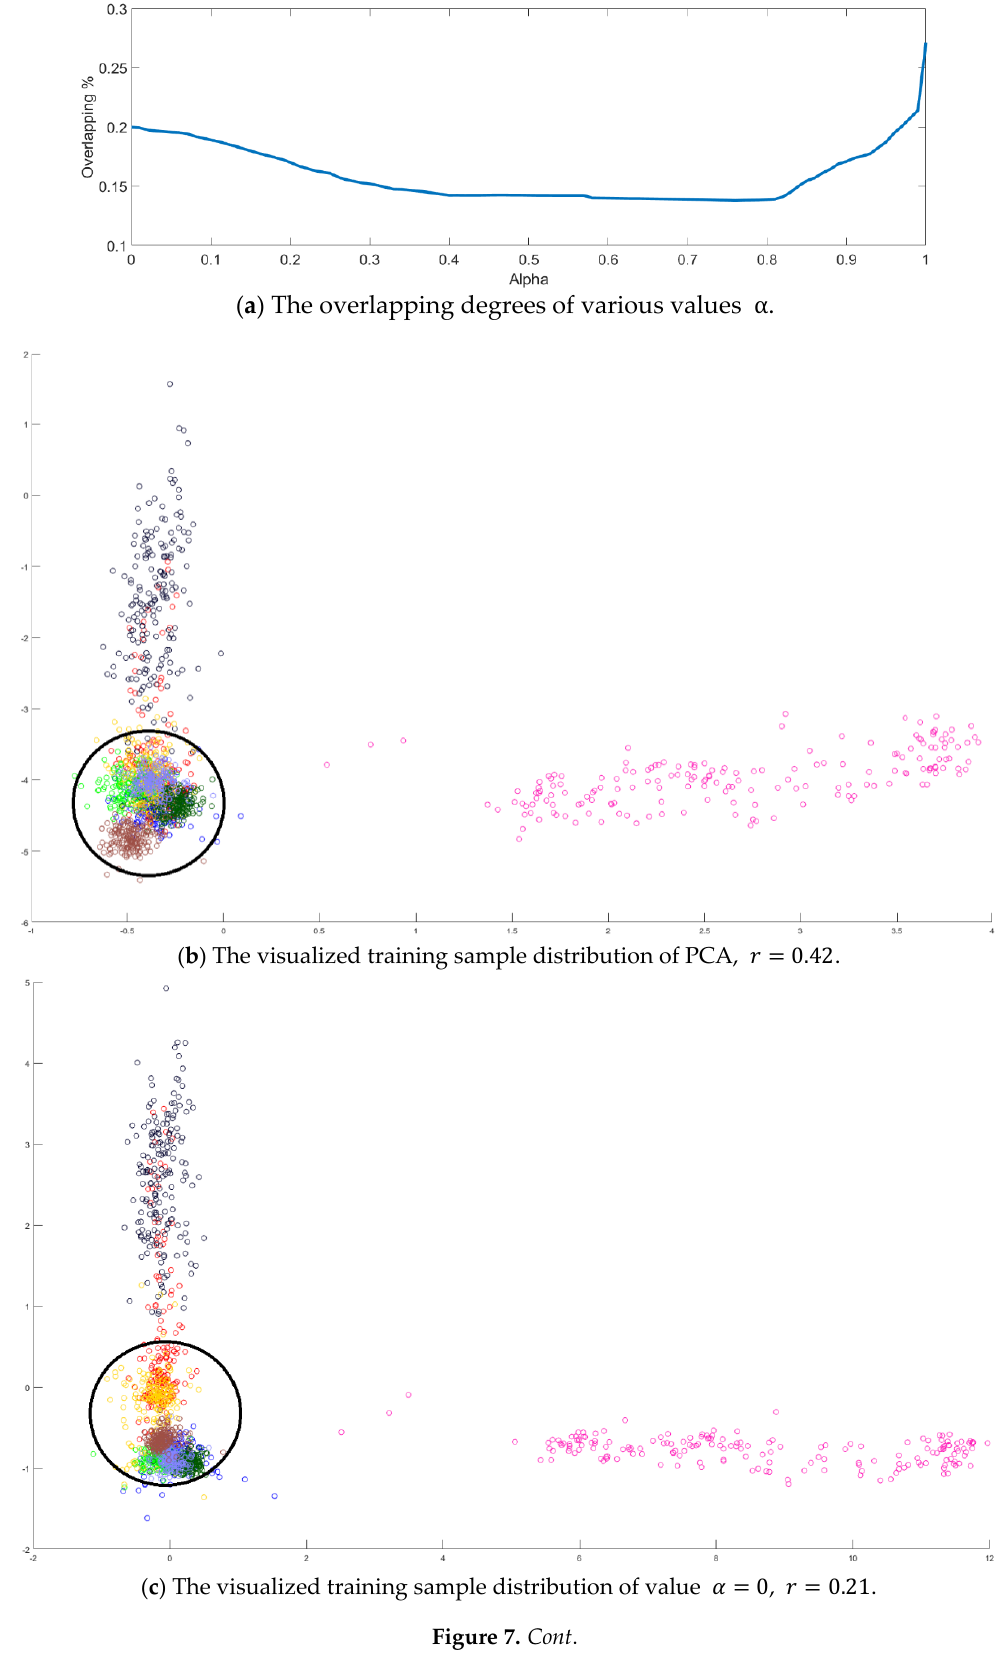
Figure 6. Dataset Pavia University: ( a ) False color image; ( b ) Class label map.